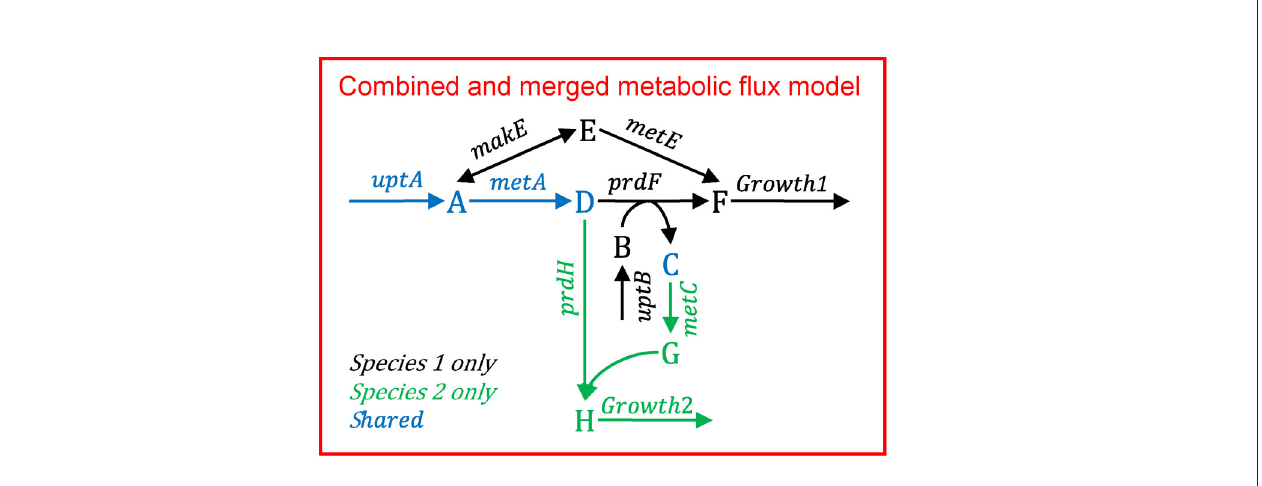
FIGURE B1.3 | Multi-species metabolic flux modeling—aggregated model. After Figure S2 in Taffs et al. (2009). The metabolic models for each species (as shown in Figure B1.2 ) are merged into one model.